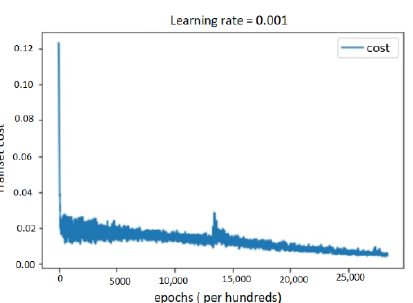
Figure 9. Training cost versus epochs for bimodal (text + audio) modality.